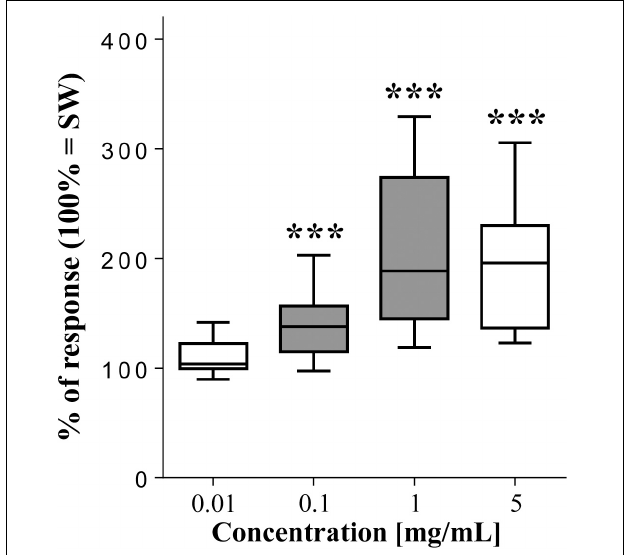
FIGURE 2 | Normalized movement rate of sea urchins, recorded as mean square difference in light intensity (summed peak heights for each preparation during a 2-min stimulation) ± se (vertical bars), following supply of the blue-green algae Spirulina compared to seawater (SW = 100% of response). The top and bottom of the box and whisker plots show the upper and lower quartiles, respectively. The horizontal line in the middle indicates the median of the corresponding distribution, while the minimum and maximum observed values are indicated by the bars connected to the box. ∗∗∗ indicates a significant difference ( p < 0.001, T -test) with respect to SW. Filled boxes indicate significant differences between a concentration and the next lower ( p < 0.01, T -test). Data were obtained from 15 sea urchins.